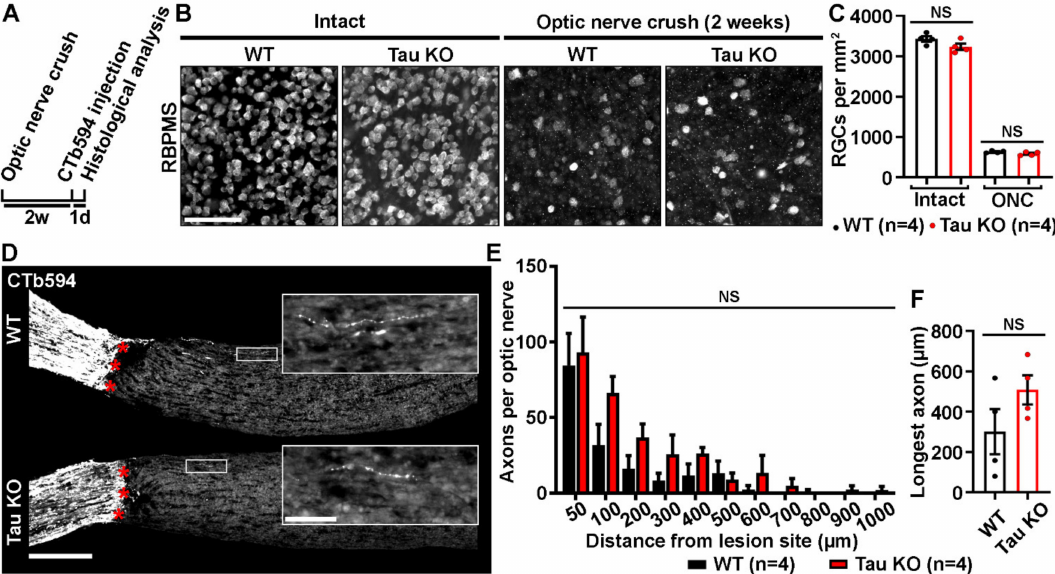
Figure 2. Tau deletion does not influence retinal survival and axonal growth. ( A ). Experimental timeline. Optic nerve crush (ONC) was performed on the left eye of WT and Tau KO mice. Two weeks later, axons were traced with CTb594 the day before animal sacrifice. ( B ). Influence of Tau expression on the survival of retinal ganglion cells (RGCs) 2 weeks after ONC in WT and Tau KO mice. Flat-mounted retinae were immunostained for RNA-Binding Protein with Multiple Splicing (RBPMS) to determine RGC density. Scale bar: 50 µ m. ( C ). Quantitative analysis of RGC survival did not show di ff erence between WT and Tau KO mice ( n = 4 mice per group). Data are expressed as mean / mm 2 ± S.E.M. Statistics: Student’s t-test. NS: Non-significant. ( D ). Influence of Tau deletion on axonal outgrowth at 2